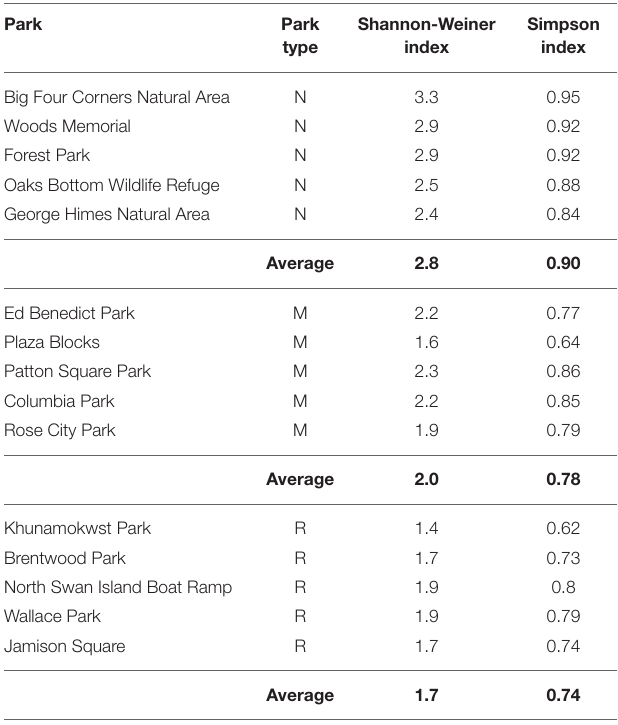
TABLE 3 | Diversity indices for each park and park type (N, natural-passive use; M, multi-use; R, recreational-active use). Park